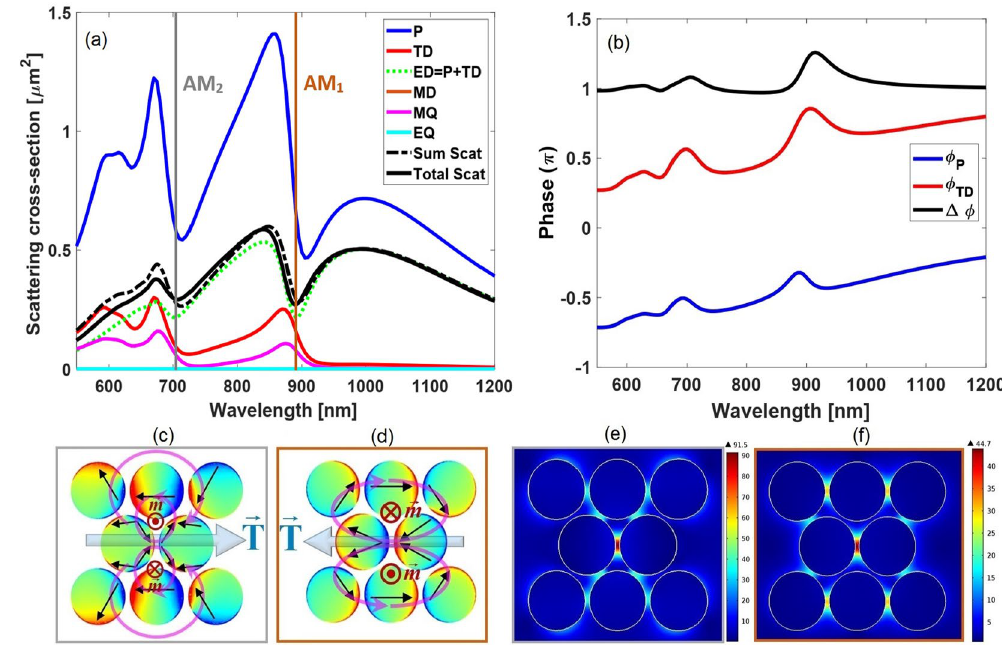
Figure 2. ( a ) The simulated SCS spectra for our proposed oligomer as well as contributions of the five dominant multipole moments to the total radiated field. “Sum Scat” states for the SCS as the sum of the multipole contributions;“Total Scat” states for the total SCS calculated directly in COMSOL (See “Computational methods”). The labels P, MD, EQ, MQ, and TD denote electric dipole, magnetic dipole, electric quadrupole, magnetic quadrupole, and toroidal dipole modes, respectively . Also, AM 1 and AM 2 represent the so-called first- and second-order anapole states with characteristic wavelength, respectively . ( b ) The phases of the electric dipole φ P and toroidal dipole φ TD moments as well as their difference �φ versus wavelength. The surface charge density distribution is shown at ( c ) AM 2 wavelength and ( d ) AM 1 wavelength. Distribution of electric field amplitude (cid:31) | E | (cid:30) | E inc | (cid:29) in the mid-height plane of the oligomer at ( e ) the second- and ( f )